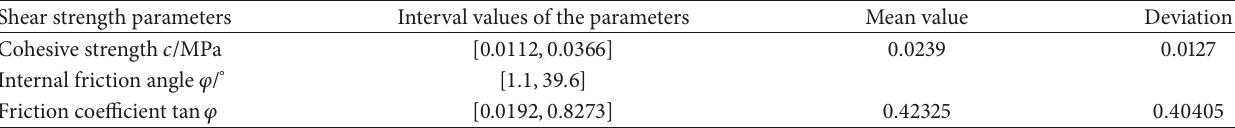
Table 4: The interval values of the shear strength parameters.